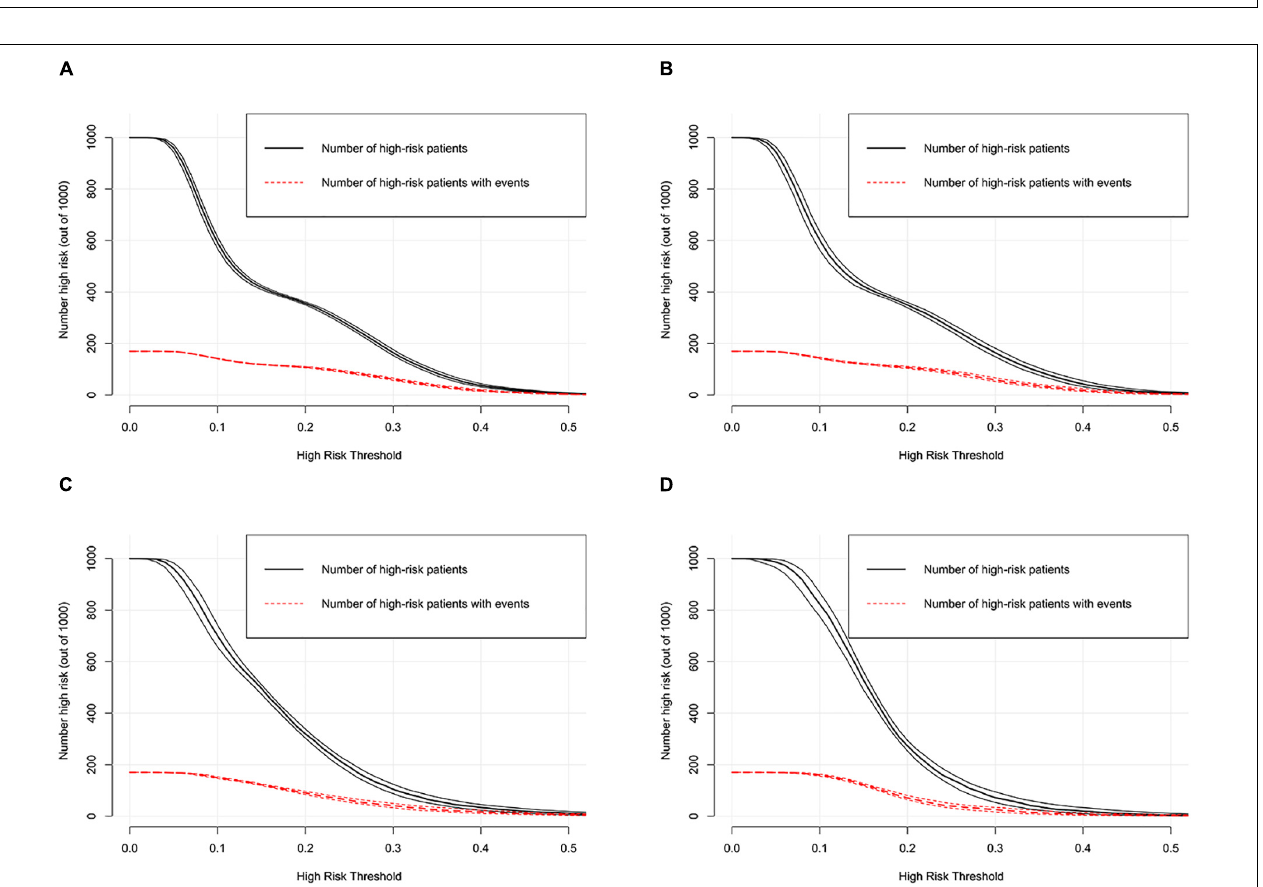
FIGURE 6 | Clinical impact curve of the nomogram in training set (A) , internal validation set (B) , external validation set1 (C) and external validation set2 (D) .